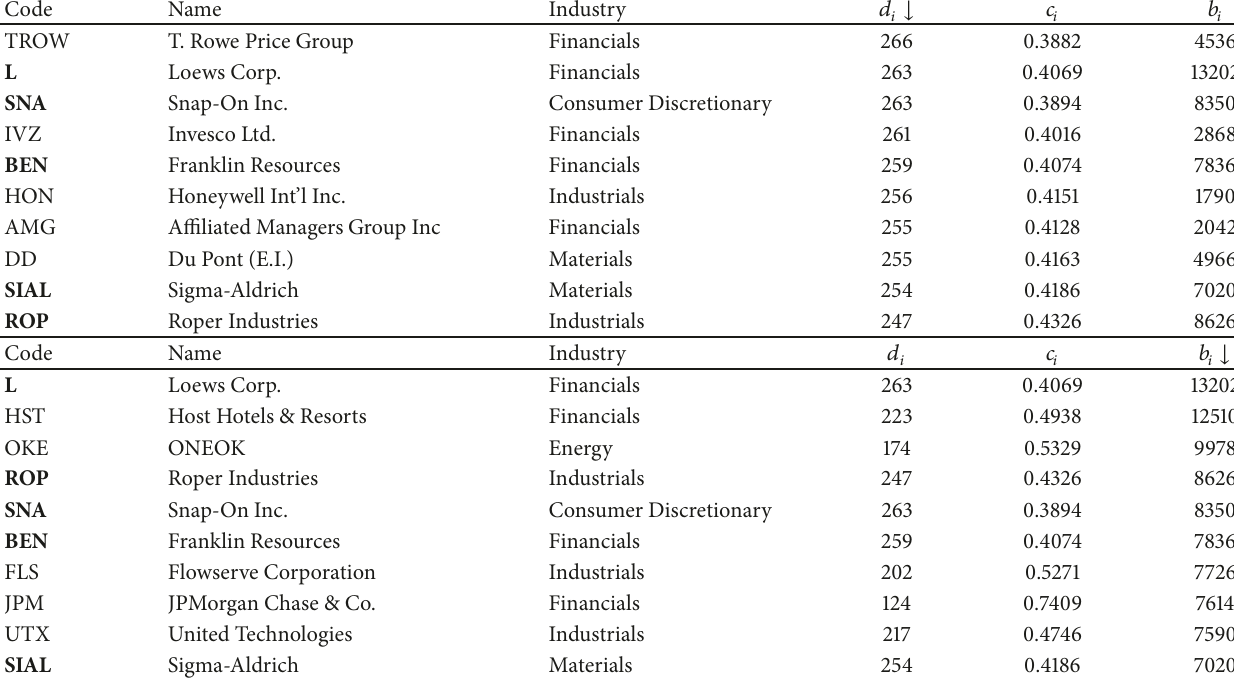
Table 9: Top stocks with highest values of degree 𝑑 𝑖 , and betweenness 𝑏 𝑖 ranked in descending order of 𝑑 𝑖 and 𝑏 𝑖 when the 𝜃 = 0.8 for S&P468 network. Stock codes in bold indicate the stocks appear at both top 10